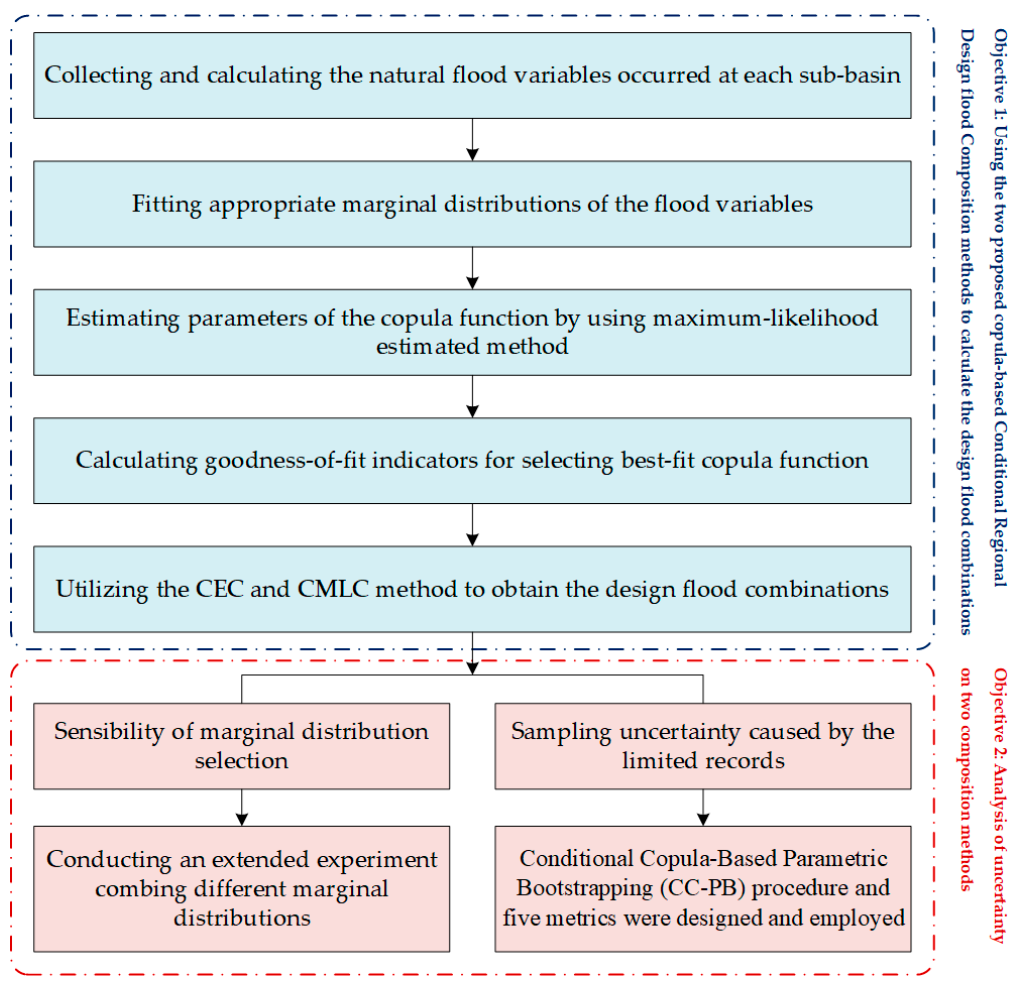
Figure 1. Flowchart of the proposed methods in this paper.